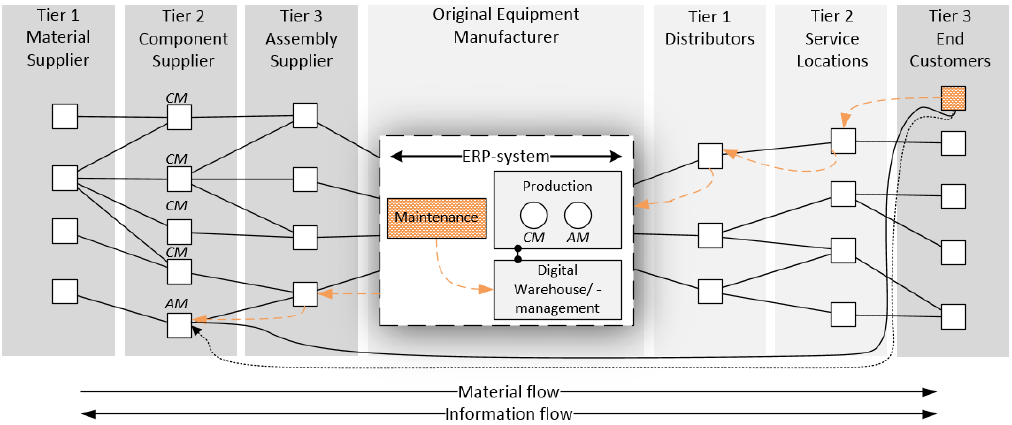
Figure 1. Supply chain network structure showing demands and potential distribution scenarios. Adapted and modified from Lambert et al. Adapted from [34]. CM: conventional manufacturing; AM: additive manufacturing; ERP: enterprise resource planning.